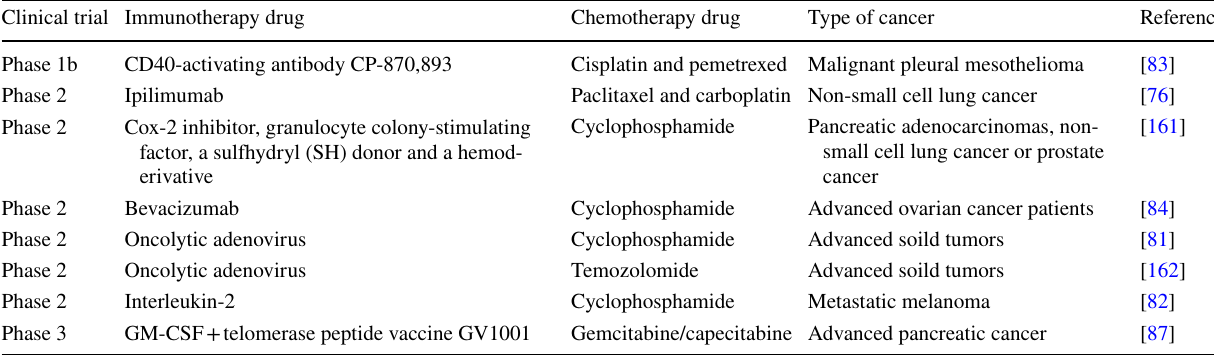
Table 2 Summary of clinical trials for cancer chemoimmunotherapy Clinical trial Immunotherapy